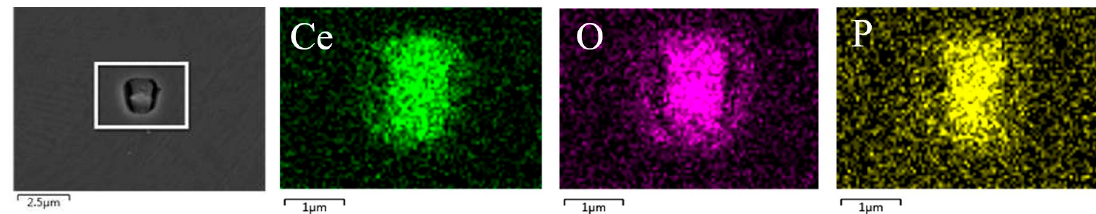
Figure 4. The morphology and composition of the typical Ce–O–P homogeneous composite inclusion.